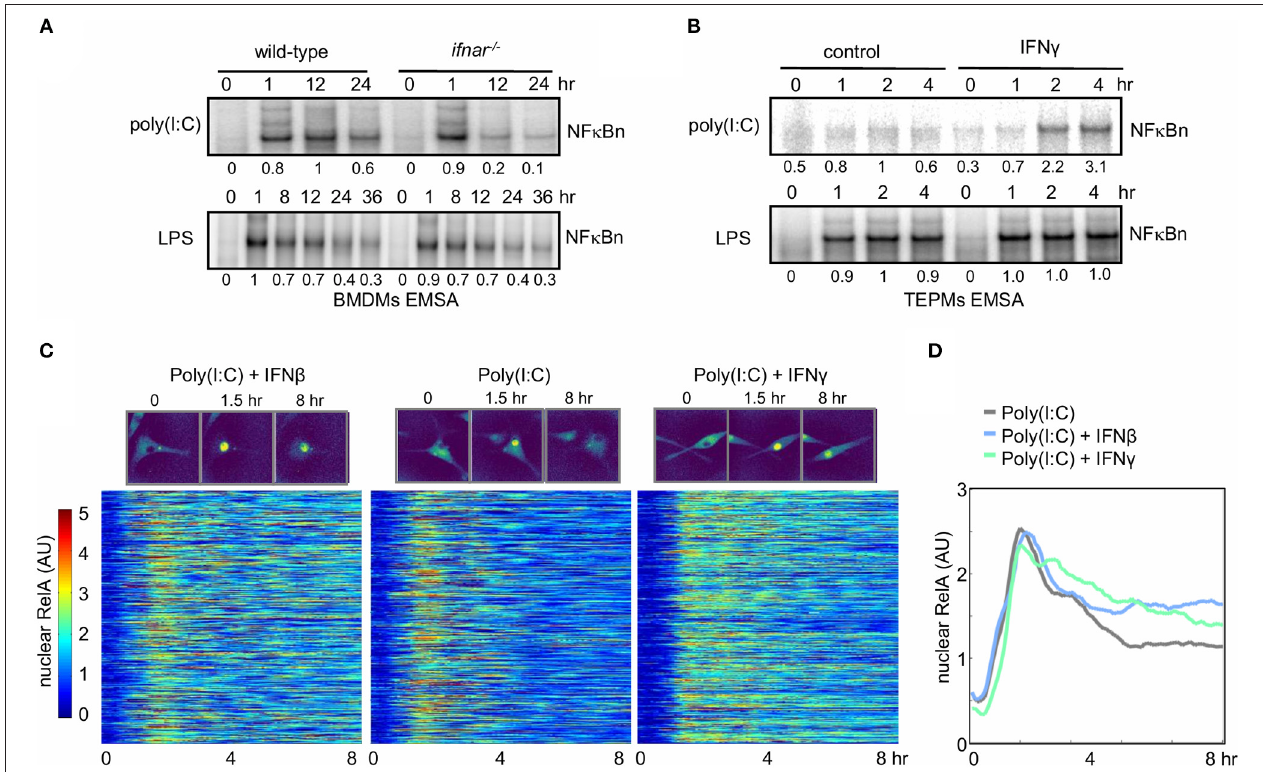
FIGURE 2 | Interferons potentiate NF κ B activation in response to the viral PAMP poly(I:C). (A) Electrophoretic mobility shift assay (EMSA) of nuclear NF κ B activity in wild-type and ifnar − / − BMDMs stimulated with LPS and poly(I:C). Quantitated activity is indicated below each band. (B) EMSA of nuclear NF κ B activity in TEPMs cultured with or without IFN γ for 24h prior to exposure to poly(I:C) or LPS. (A,B) show data representative of three biological replicates. Quantitations of phosphorimager data are relative to peak activity in controls which is set to 1. (C) Single-cell tracking of RelA-mVenus localization in 577 Poly(I:C) stimulated BMDMs cultured in the absence or presence (24h) of IFN β and IFN γ . Nuclear NF κ B activity is indicated as nuclear:cytoplasmic ratio. The time-course response of each tracked cell is displayed as a row in the heatmap with brighter colors corresponding with increasing nuclear localization of NF κ B. (D) The average nuclear NF κ B activity of 577 tracked cells is shown for naïve and IFN β - and IFN γ -primed conditions. (C,D) show data representative of two biological